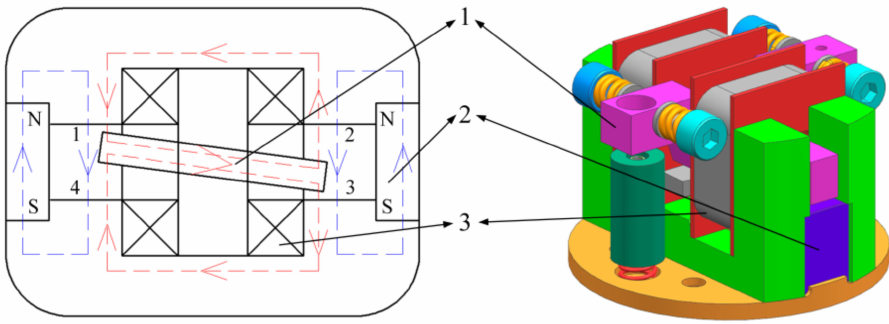
Figure 4. Torque motor schematic diagram. 1. armature; 2. permanent magnet; 3. coil.